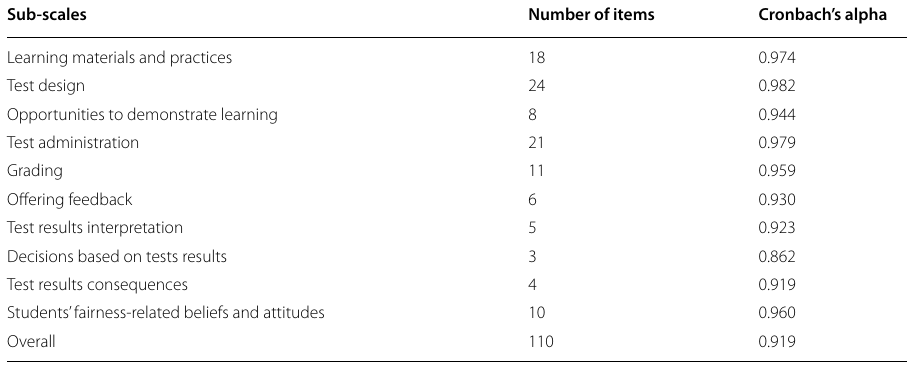
Table 5 Reliability of the sub-scales and the final version of the